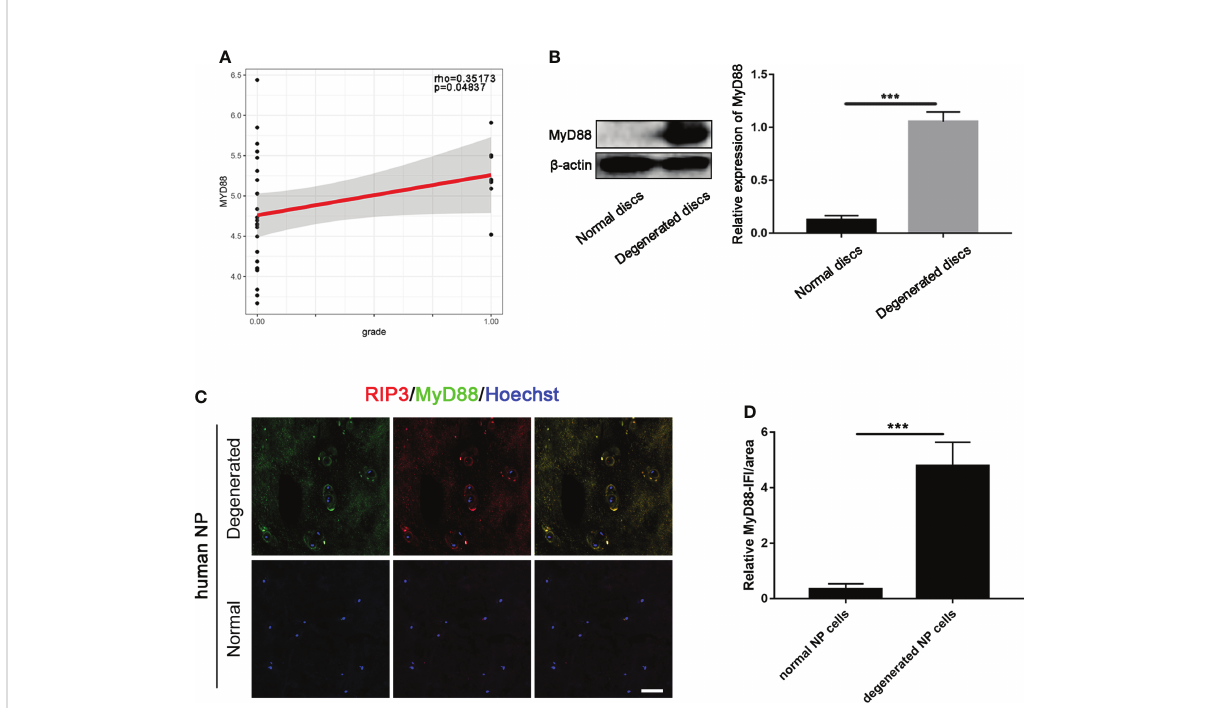
FIGURE 3 Expression of MyD88 in normal and degenerated disc. (A) The correlations of the expression of the MyD88 with IVDD grades by linear regression analysis. ( “ 0.00 ” means early stage-thompson grade III, IV, “ 1.00 ” means advanced stage-thompson grade V). (B) Detection of MyD88 levels in normal and degenerated disc by western blot. ***P < 0.001. (C) Double-staining of RIP3 with MyD88 in NP cells in normal and degenerated disc. (D) Relative IF intensity of MyD88 in NP cells. ***P < 0.001. N = 6. Bar = 50 m